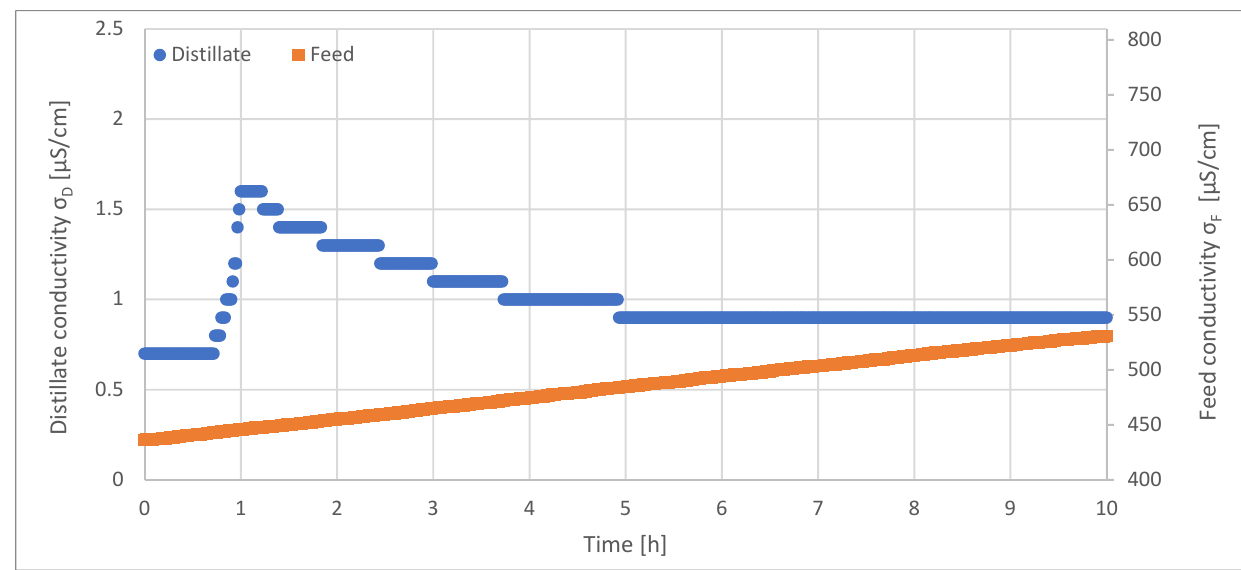
Figure 13. Feed and distillate conductivity during long-term investigations of VMD. T F = 56.5 °C, F F = 45 L/h, F K = 130 L/h, T K,in = 13.1 °C, Δ p = − 0.1 bar.